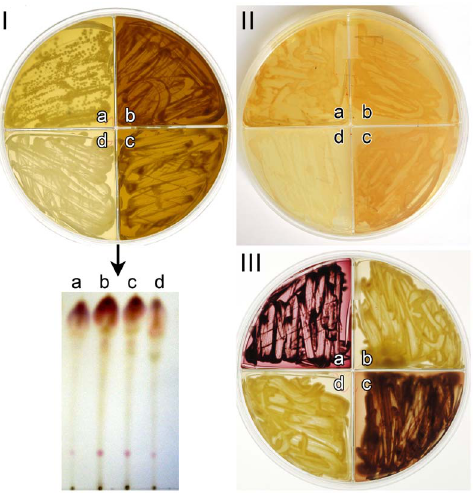
Figure 9. Laccase mutants of Cryptococcus. C. neoformans var. neoformans grown on m-LTG agar for two weeks (section I), quadrant a (2ETU-C), quadrant b (B3501), quadrant c (JEC21) and quadrant d (2ETU, laccase mutant). The laccase mutant failed to produce the brown pigment. Similar results were obtained when the same strains were cultured on D-tryptophan (m-FDTG agar) (section II). C. neoformans var. grubii grown on m-FLTG agar for two weeks (section III), quadrant a (H99, lac 1 and lac 2 positive), quadrant b (MDJ12 ( lac 1 mutant), quadrant c RPC26 ( lac 2 mutant), and quadrant d QGC8 ( lac 1 and lac 2 double mutant). When lac 1 was deleted, production of the pink pigment was significantly reduced. The TLC illustrated that when the pink pigment was produced intracellularly the laccase mutant of C. neoformans var. neoformans (2ETU) (column d) produced reduced amounts of the pink